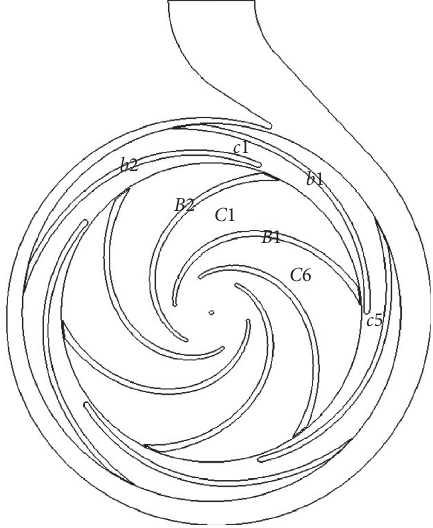
Figure 5: Structure of the centrifugal